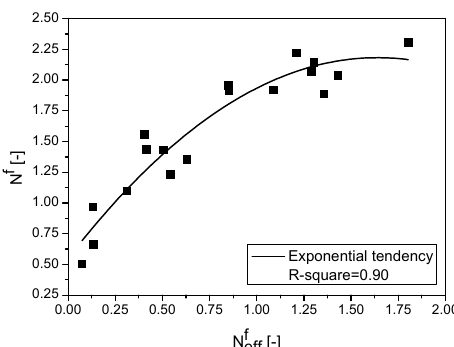
Figure 10: Number of the fibres, f N , versus number of the effective fibres, f